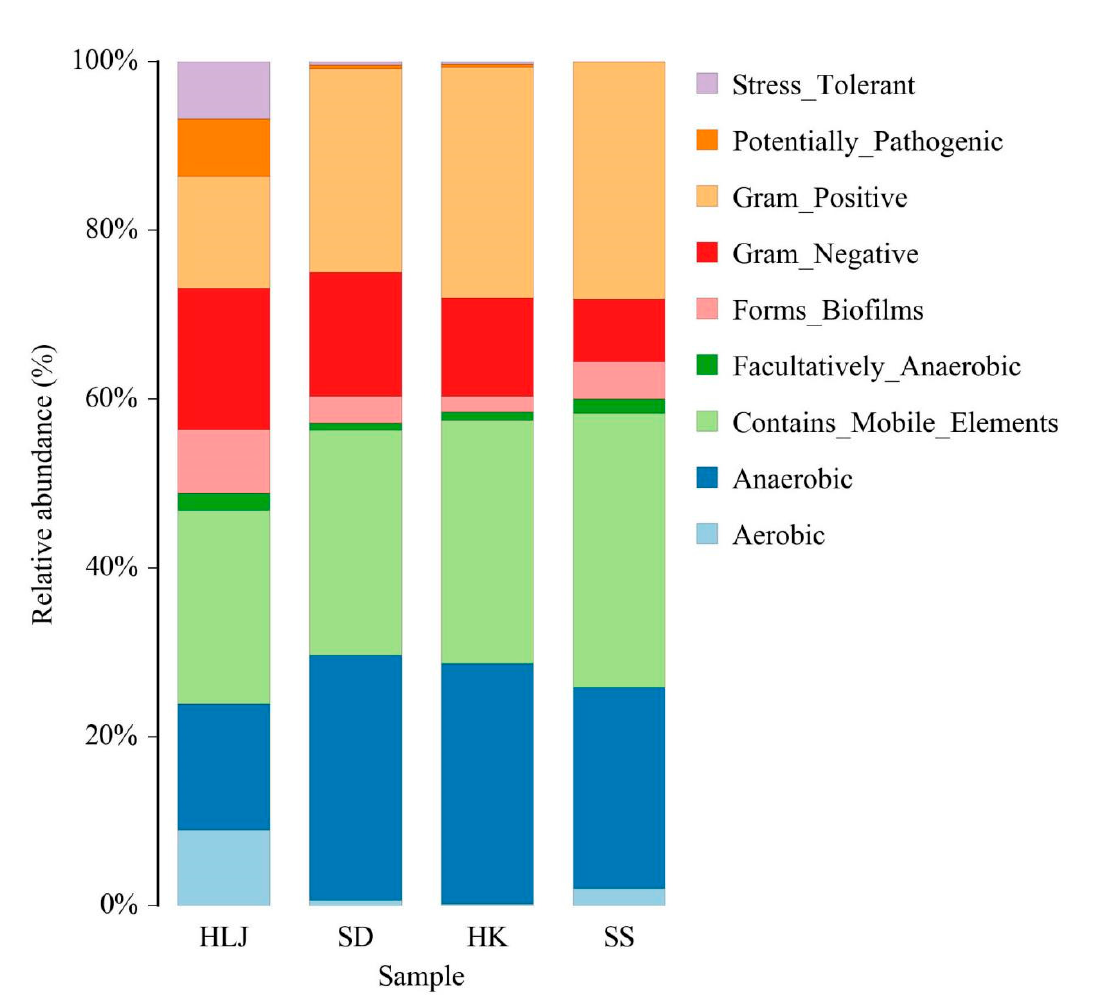
Figure 6. Differences in microbiota phenotype among different sampled locations.